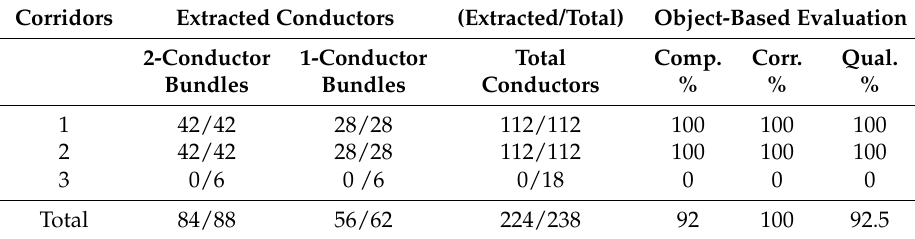
Table 6. Objected-based evaluation of conductor extraction in Maindample site.